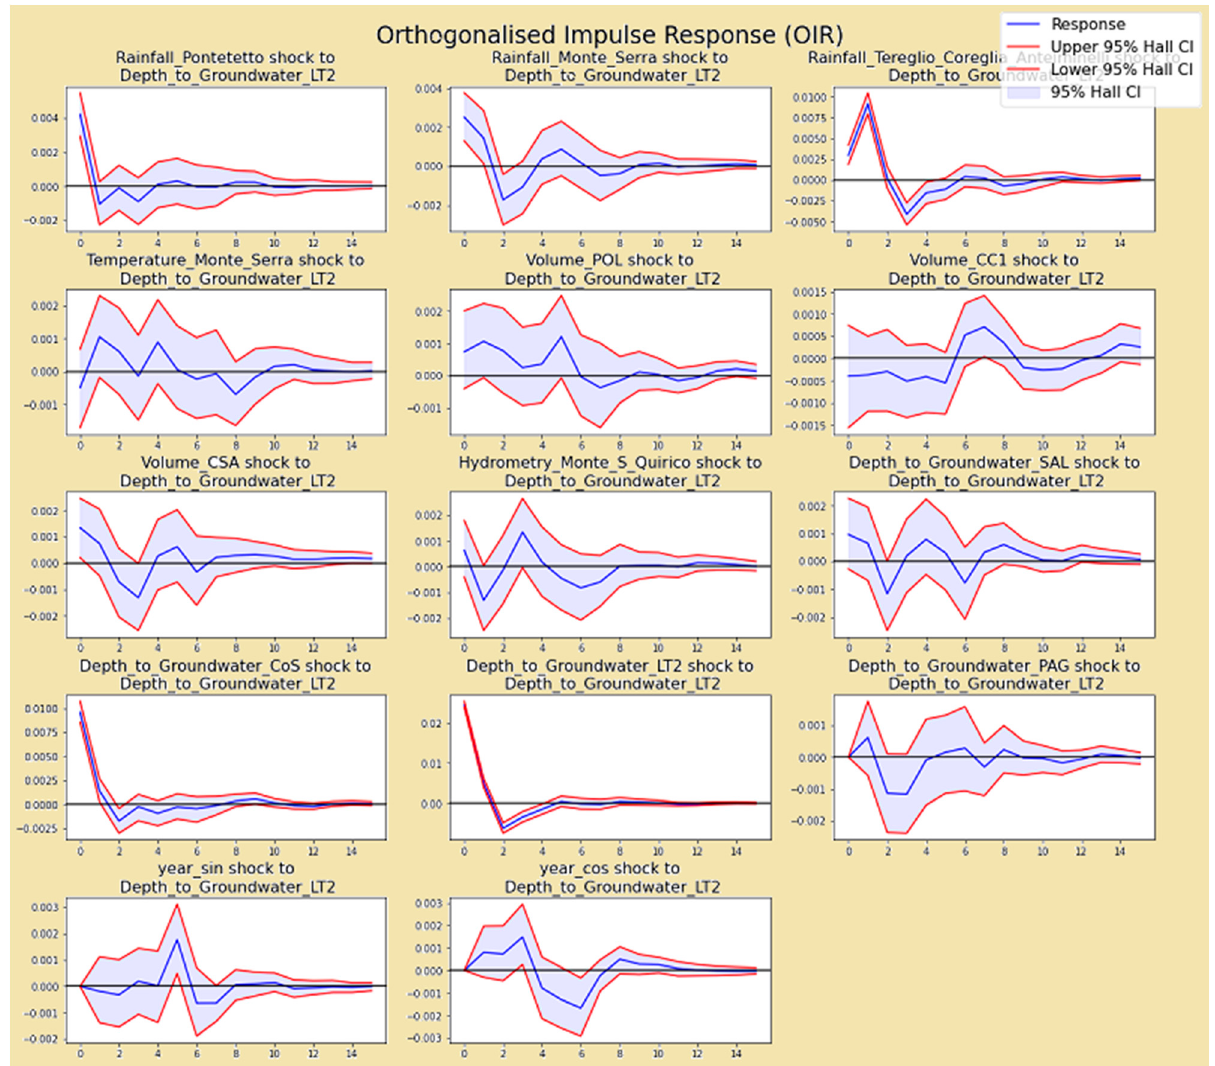
Figure 7. OIR plot for Depth_to_Groundwater_LT2